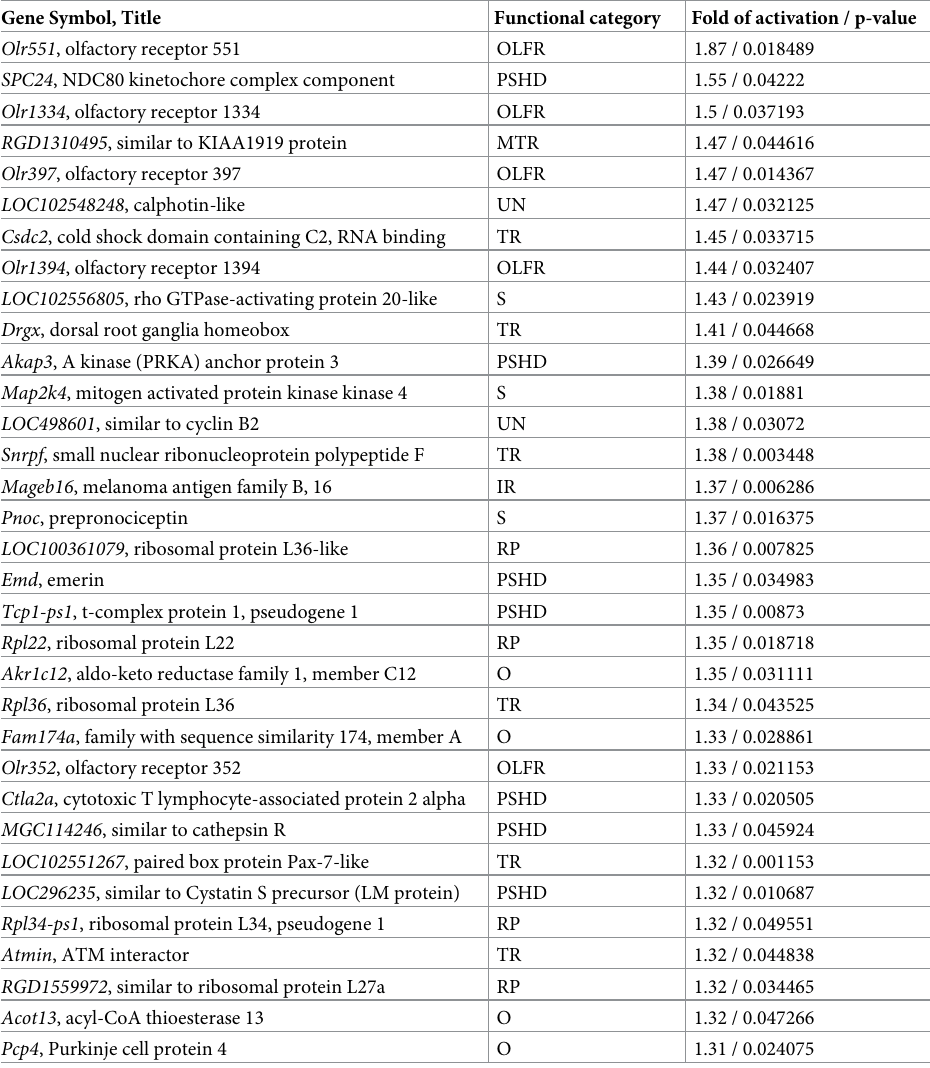
Table 4. Genes whose expression was increased by 100 nM ouabain by more than